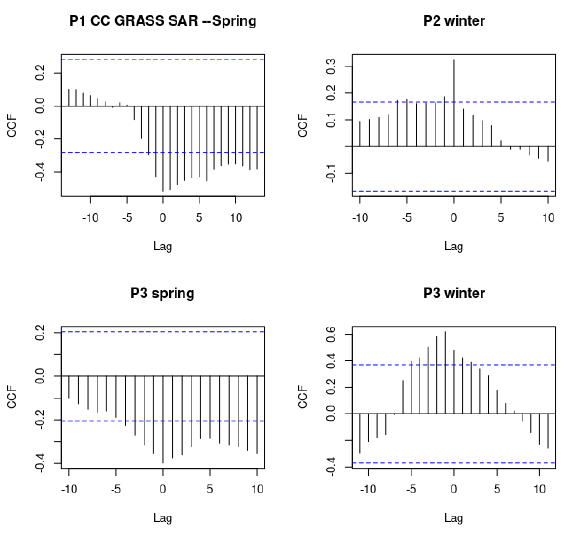
Figure 3. Seasonal variation of the cross correlation function (CCF) between the inundated areas calculated with GRASS from the lake water level and from Sentinel-1 (SAR), lags are expressed as days. The blue dashed lines are referent to a significance interval, the bars that run through these lines have statistical